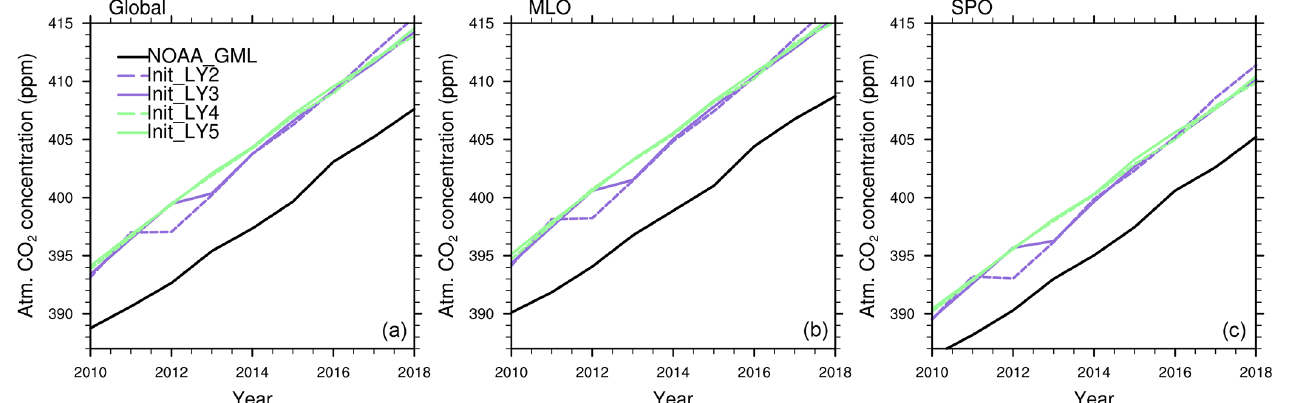
Figure A5. Atmospheric CO 2 concentration from initialized simulations at a lead time of 2–5 years together with NOAA_GML observations (Dlugokencky and Tans, 2020) over the last 10 years. The time series are original model outputs and concatenated according to the lead time of